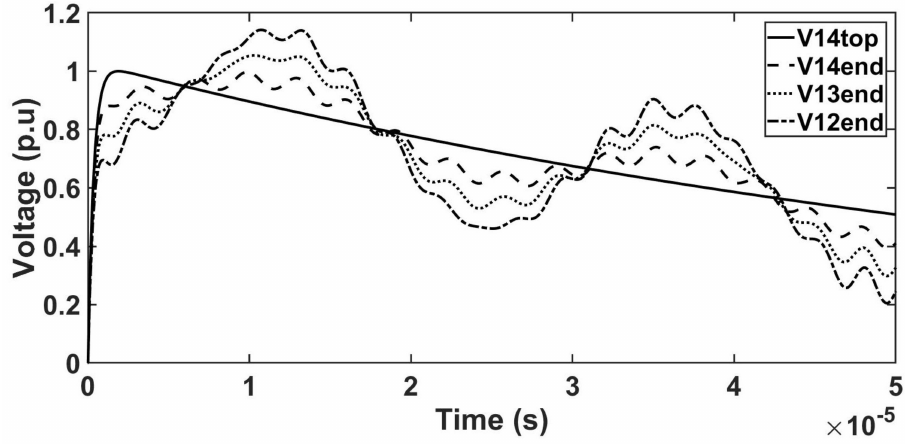
Figure 16. Surge voltage waveforms for shield placement between layer 14 and layer13 of HV winding under